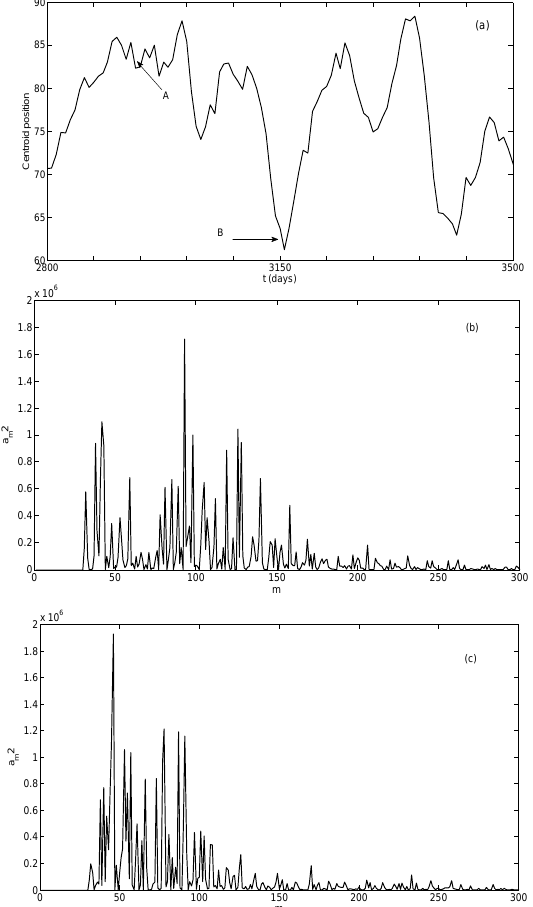
Figure 8. An evolution of the spectral centroid. (a) Spectral centroid from 5 August 1999 to 5 July 2000. A and B indicate a time interval within which the centroid moved to the lowest value. (b) Spectrum of a 2 m for point A on day 2940. (c) Spectrum of a 2 m for point B on day